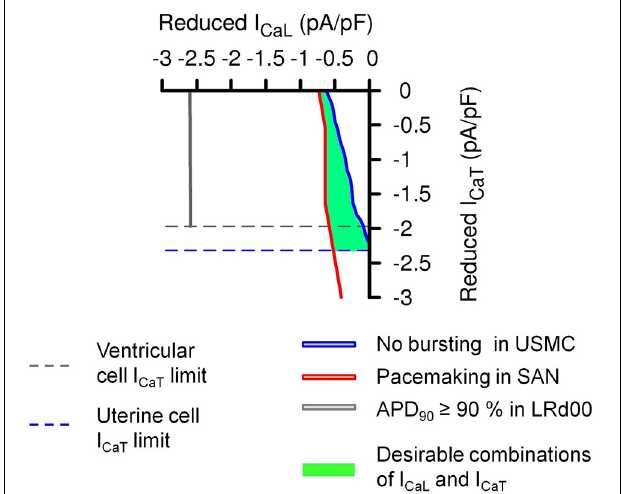
FIGURE 7 | Effects of the same absolute amounts of I CaL and I CaT reductions on the APs of the three different cell types. A transformation of the simulation results in Figure 6D using the maximum values from published experimental current densities of I CaL and I CaT ( Table 1 ) in human uterine smooth muscle cells (I CaL = 4 . 5pA pF − 1 and I CaT = 2 . 32pA pF − 1 ), guinea pig SAN cells